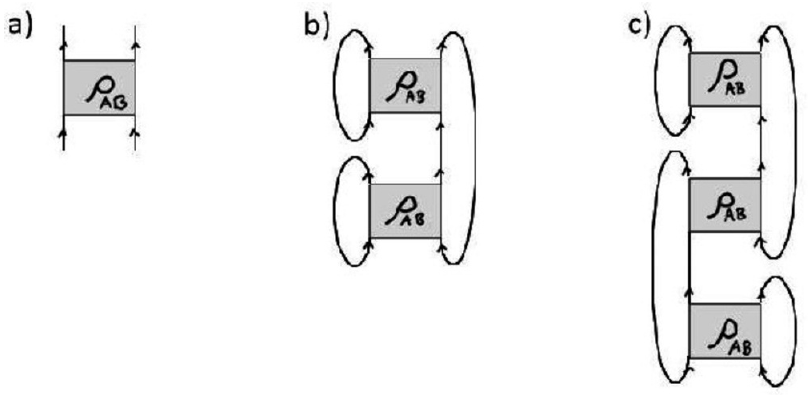
Figure 3 . Constructing invariants from a multipartite density matrix (cid:26) : a) Diagrammatic represen- tation of density matrix (cid:26) AB for a system with two parts A and B . Ingoing/outgoing lines represent indices transforming in the fundamental/antifundamental representation under the unitary oper- ation corresponding to the change of basis for a subsystem. b) Diagrammatic representation of tr( (cid:26) 2 ). c) Diagrammatic representation of S 3 ( (cid:26) AB ; (1)(23) ; B